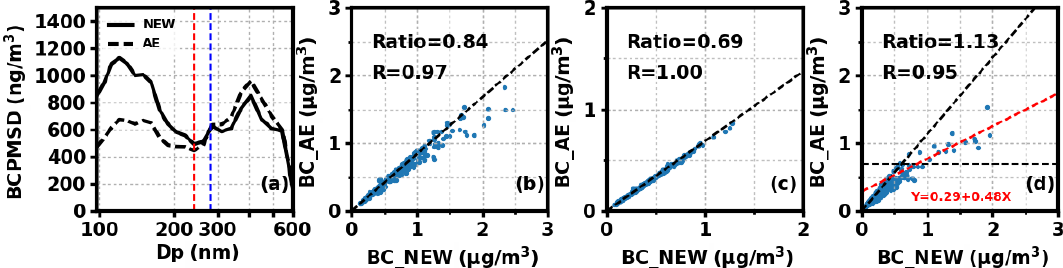
Figure 4. Comparison between the EBC derived from the new method and from a constant MAC of 7.77m 2 /g used by AE33. Panel (a) shows the results of the BCPMSD. The dashed black line is the result of a constant MAC of 7.77m 2 /g used by AE33, and the solid black line represents the results from the new method. The dashed red line is the split line of 240nm between fine mode and coarse mode, and the dashed blue line is the split line of 280nm between the opposite tendencies of deviations in the BCPMSD. (b) The bulk EBC integrated from 97 to 602nm. (c) The fine mode EBC integrated from 97 to 280nm. (d) The coarse mode EBC integrated from 280 to 606nm. The dashed black line represents the boundary of 0.7µg/m 3 and the red dashed line is the regression line for the EBC larger than 0.7µg/m 3